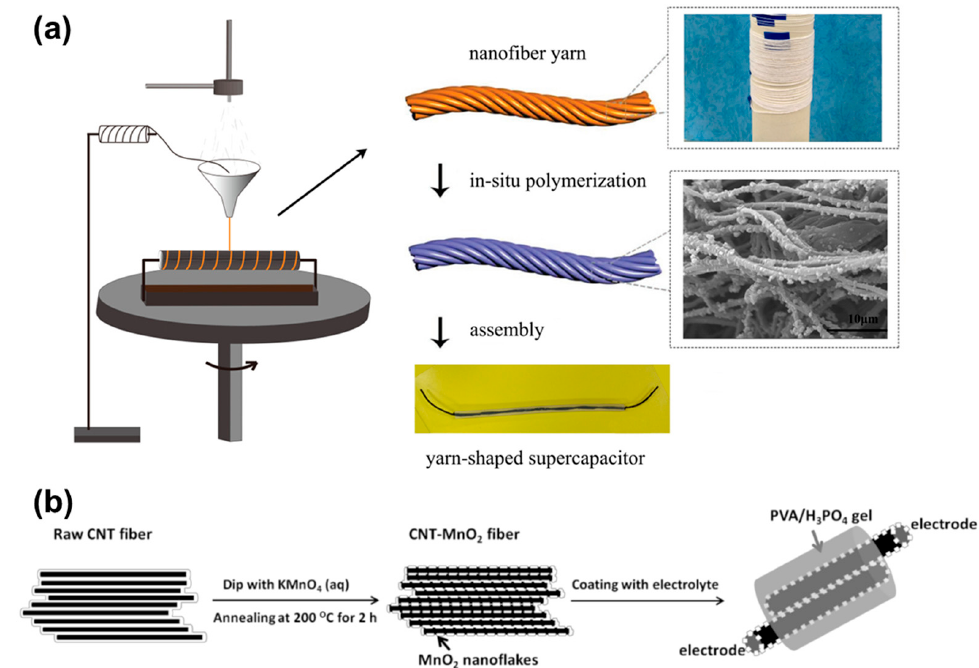
Figure 2. ( a ) Process diagram of the supercapacitor based on CNT-FF. Reproduced from ref. [12] under the Creative Commons Attribution 4.0 International (CC BY 4.0) License). ( b ) Schematic diagram of the manufacturing method of the CNT–MnO 2 supercapacitors. Reproduced from ref. [14] under the Creative Commons Attribution 4.0 International (CC BY 4.0) License).